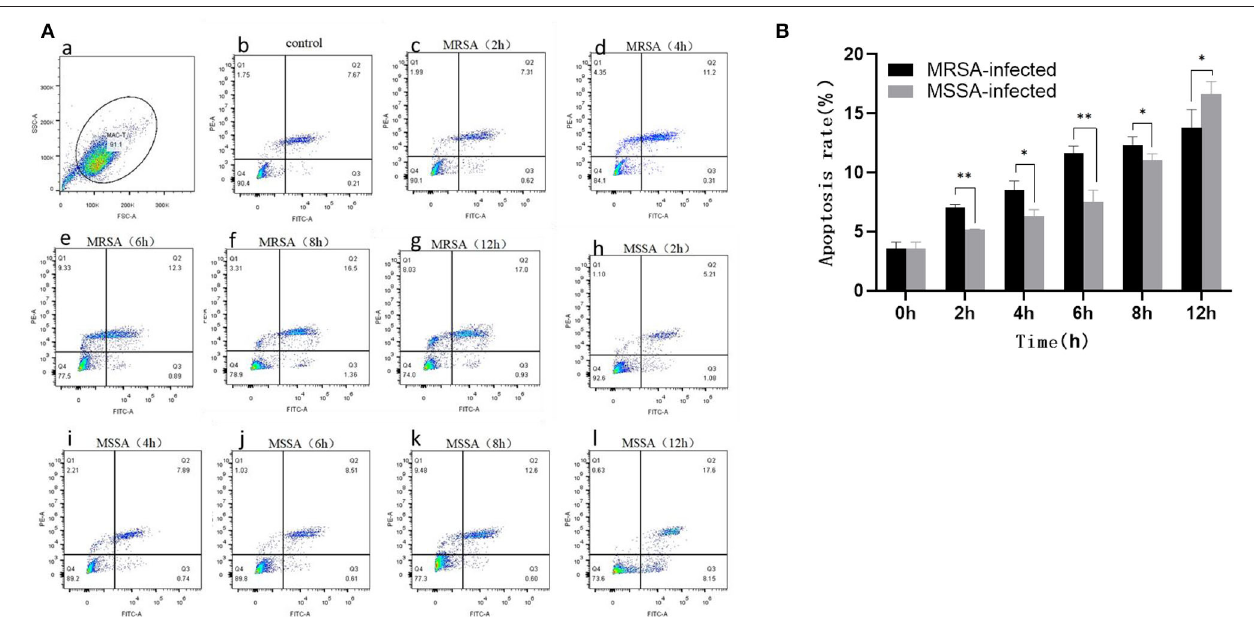
FIGURE 2 | The apoptosis rates of MRSA-infected and MSSA-infected MAC-T cells at different time periods. (A) The apoptosis rate of cells measured by flow cytometry. Q1 indicates necrotic cells (Anexin V– PI + ), Q2 indicates late apoptotic cells (Anexin V + PI + ), Q3 indicates surviving cells (Anexin V– PI–), and Q4 indicates early apoptotic cells (Anexin V + PI–). (a) The application of gating strategy in the analysis of MAC-T cell apoptosis. (b) The apoptosis rate of uninfected MAC-T cells. (c)–(g) The apoptosis rates of MRSA-infected cells at different time periods (2, 4, 6, 8, and 12h). (h)–(l) The apoptosis rates of MRSA-infected cells at different time periods (2, 4, 6, 8, and 12h). (B) The percentage of MRSA and MSSA induced apoptosis in MAC-T cells with time. * p < 0.05, ** p <